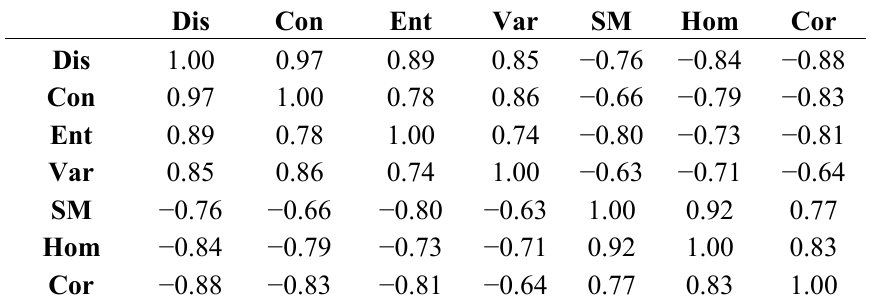
Table 2. Correlation matrix among the gray-level co-occurrence matrix (GLCM) descriptors. Dis, dissimilarity; Con, contrast; Ent, entropy; Var, variance; SM, second moment; Hom, homogeneity; Cor, correlation.